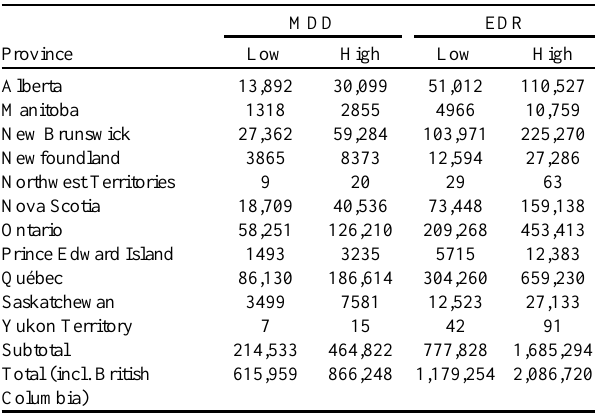
Table 6 . Total estimated number of nests destroyed by forestry operations during the migratory bird breeding season by province/territory under differing assumed nesting